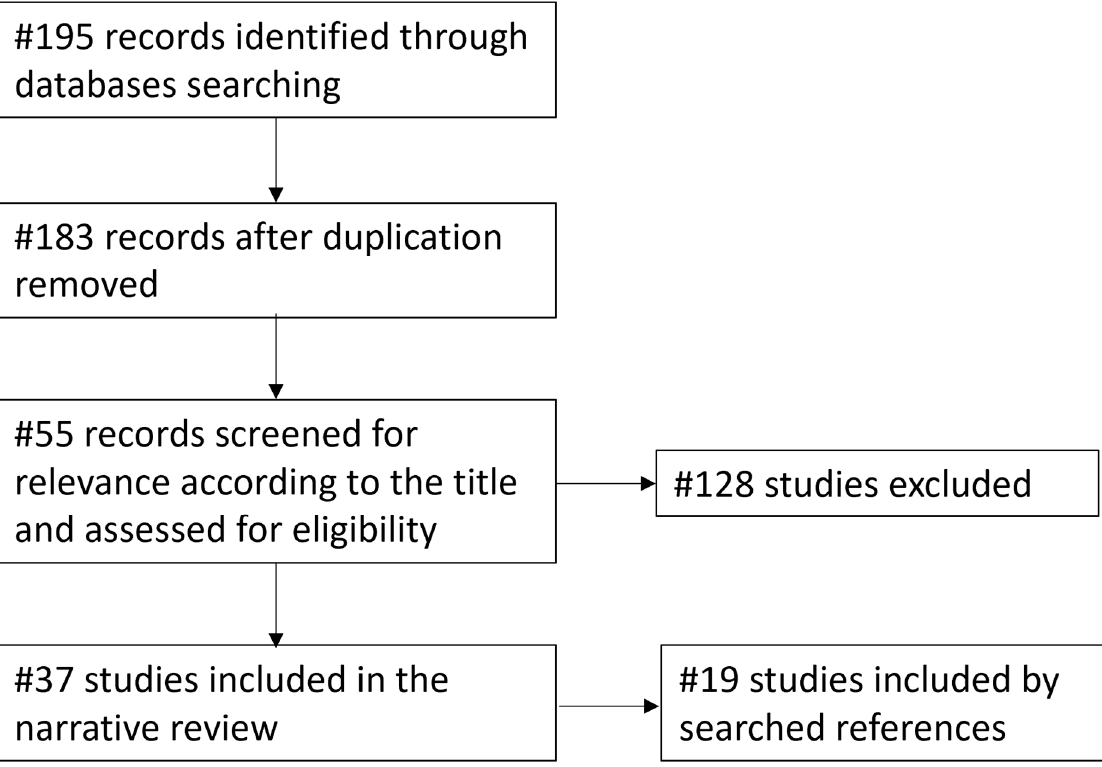
Figure 1. The process of selecting articles.